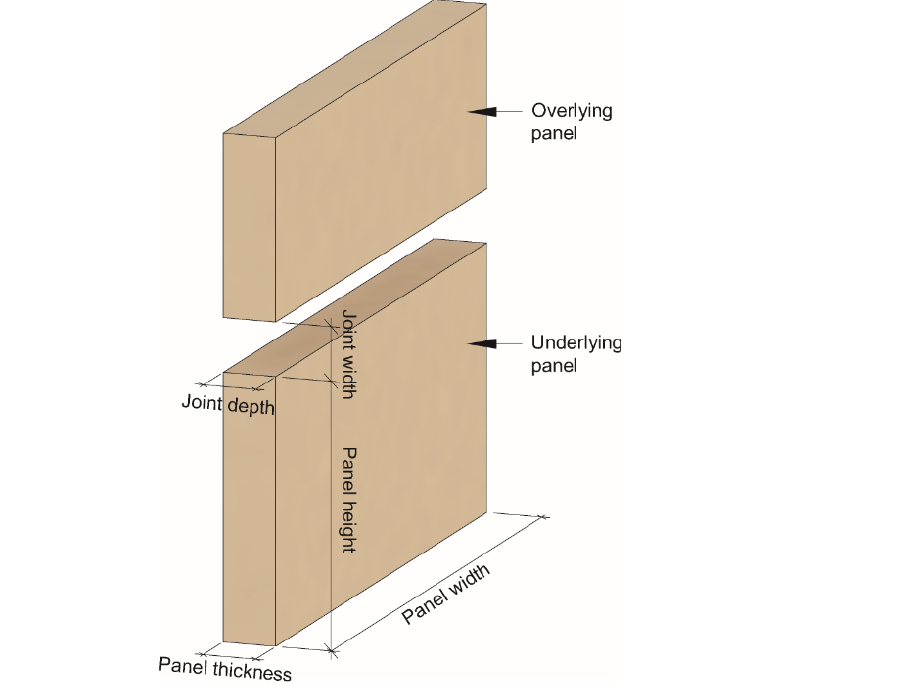
Figure 2. Definition of terms used to describe attributes of the panels and horizontal